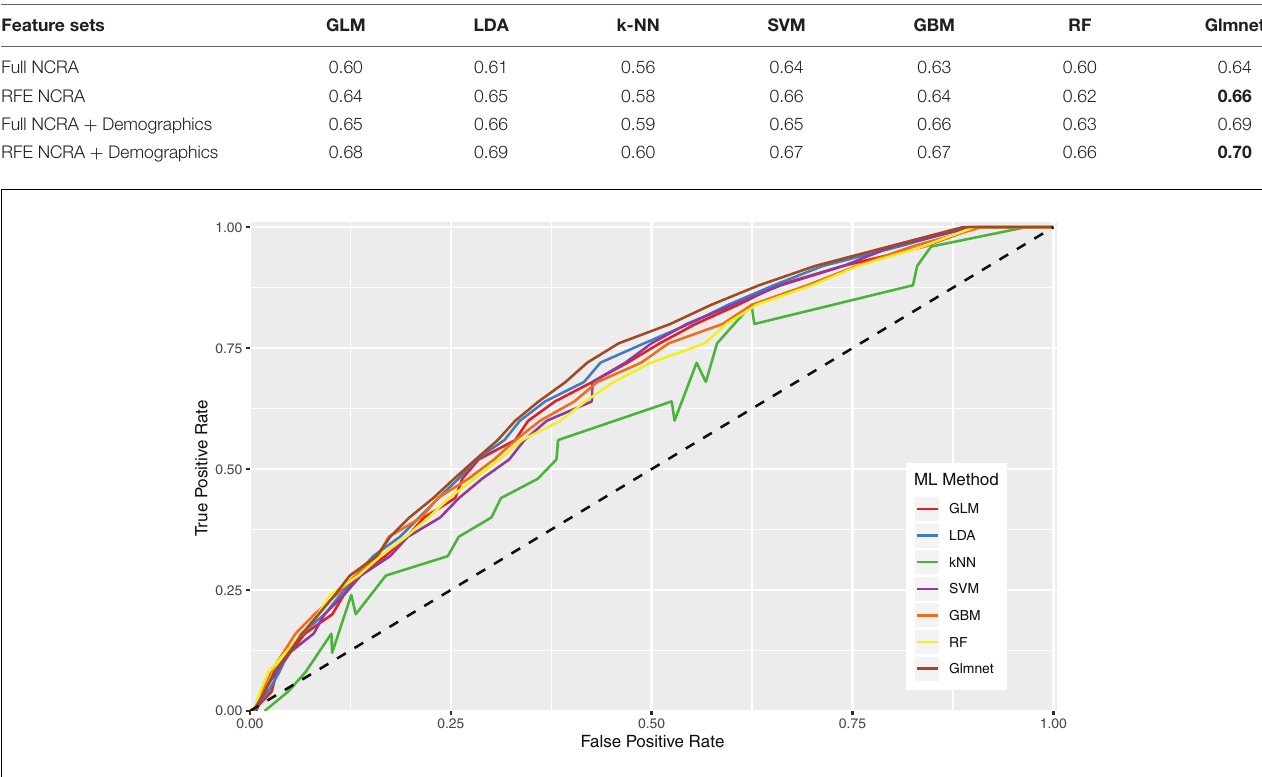
Frontiers in Psychology |